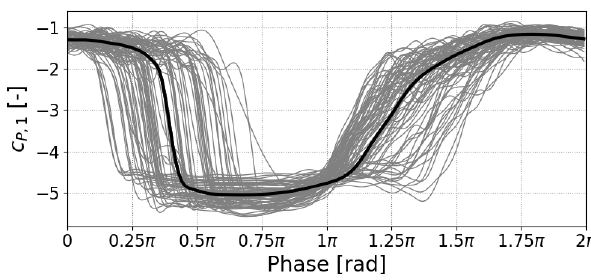
Figure 3. Soft-DTW centroid for clustered time series with strong phase jitter. (Example data from pressure sensor reading from tow- ing